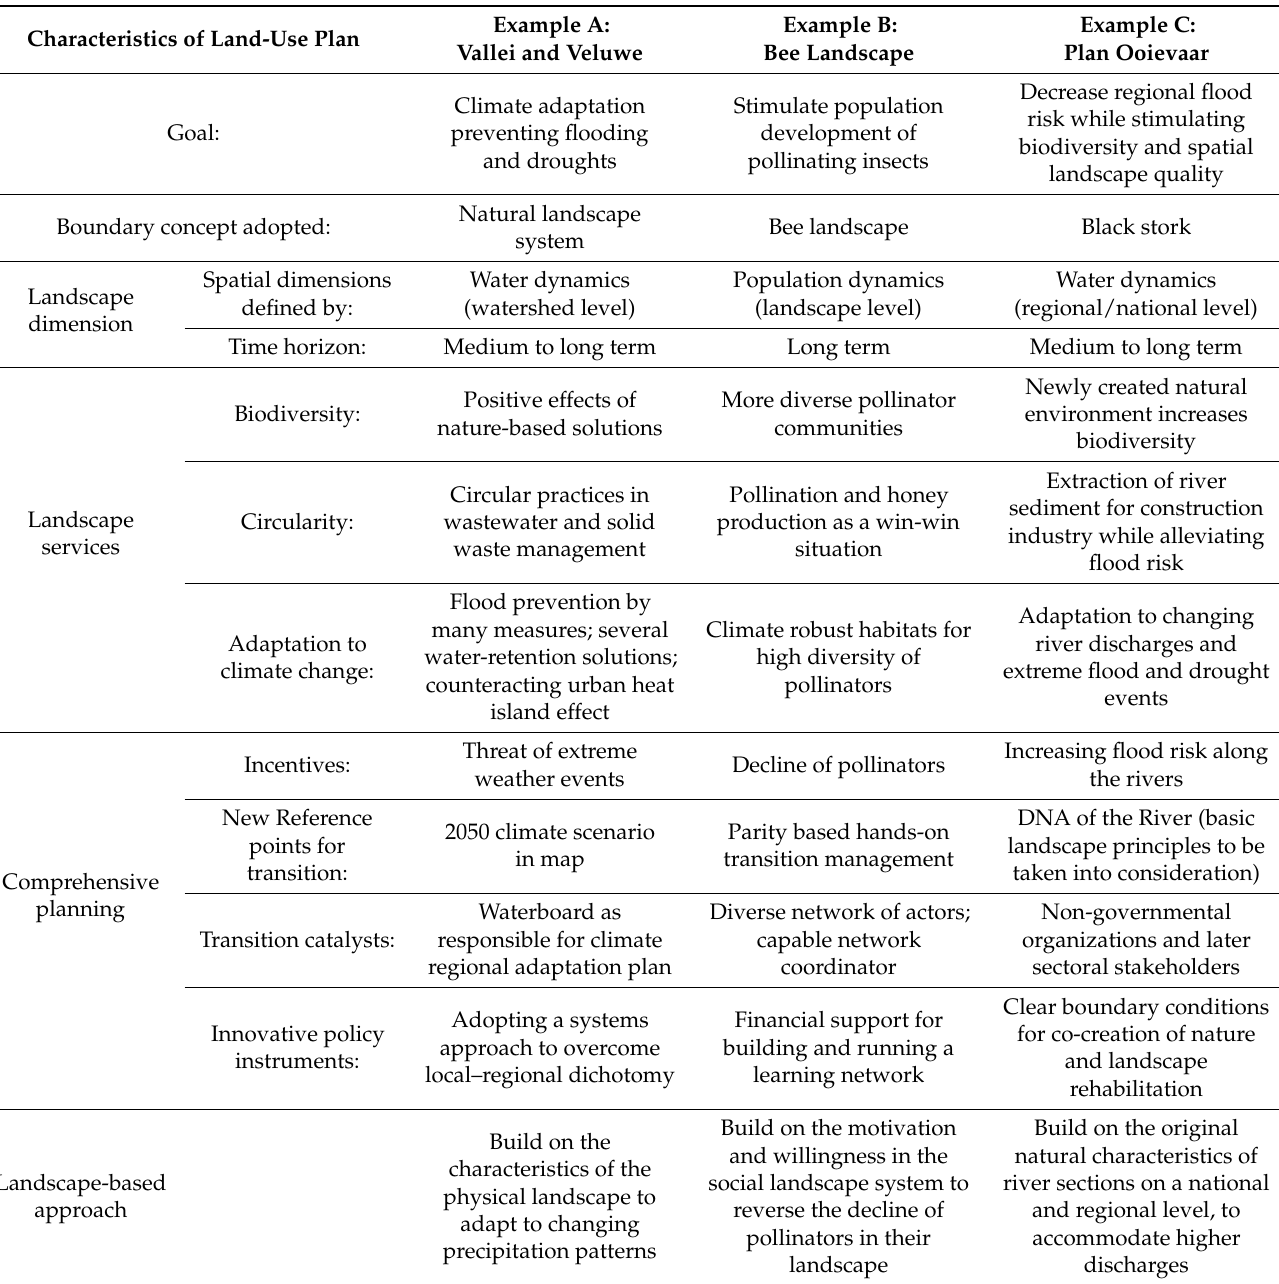
Table 1. Comparison of the